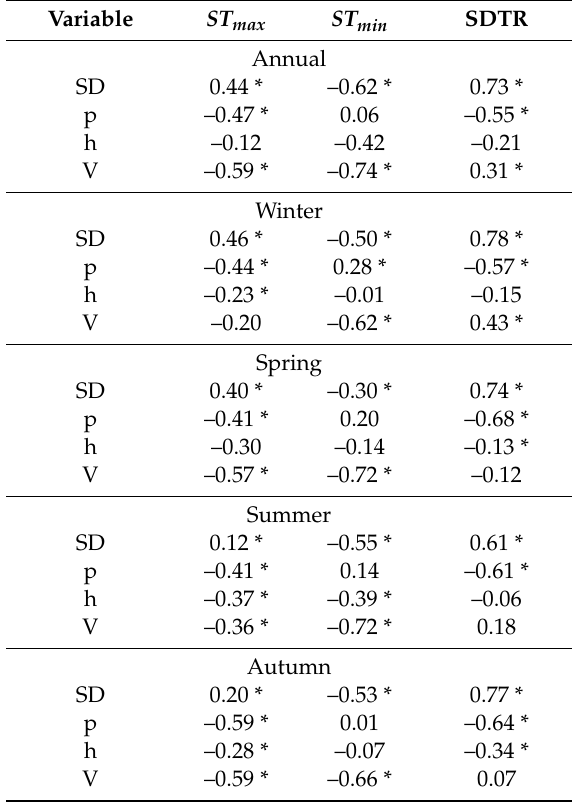
Table 3. Correlation coe ffi cients between soil temperature variables ( ST max , ST min , and SDTR) and other climatological variables including DTR, sunshine duration (SD), precipitation (p), relative humidity (h), and surface wind speed (V) on annual and seasonal scales in China during